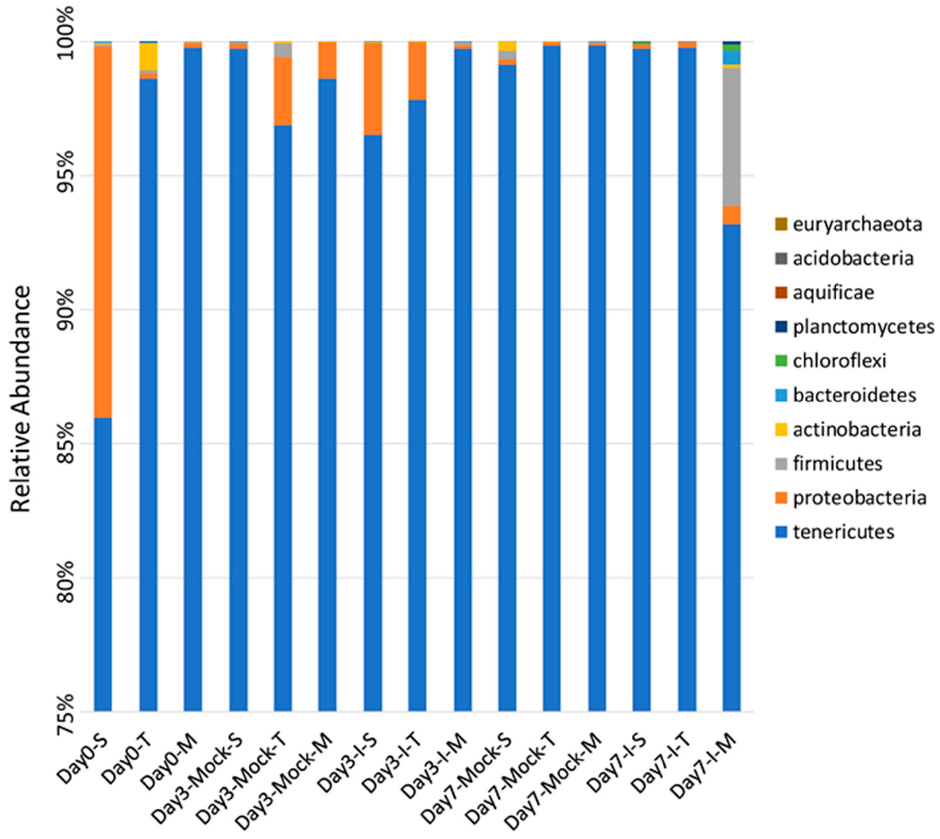
Figure 1. The mean relative abundance of prokaryote phyla in the kernels of A. flavus -susceptible and -resistant maize genotypes. S: SC212, susceptible genotype; T: TZAR102, resistant genotype; M: MI82, resistant genotype. Mock = mock control and I = A . flavus -infected. The data are mean ± standard error (SE) of 3 replicates, and each replicate consists of four seeds.